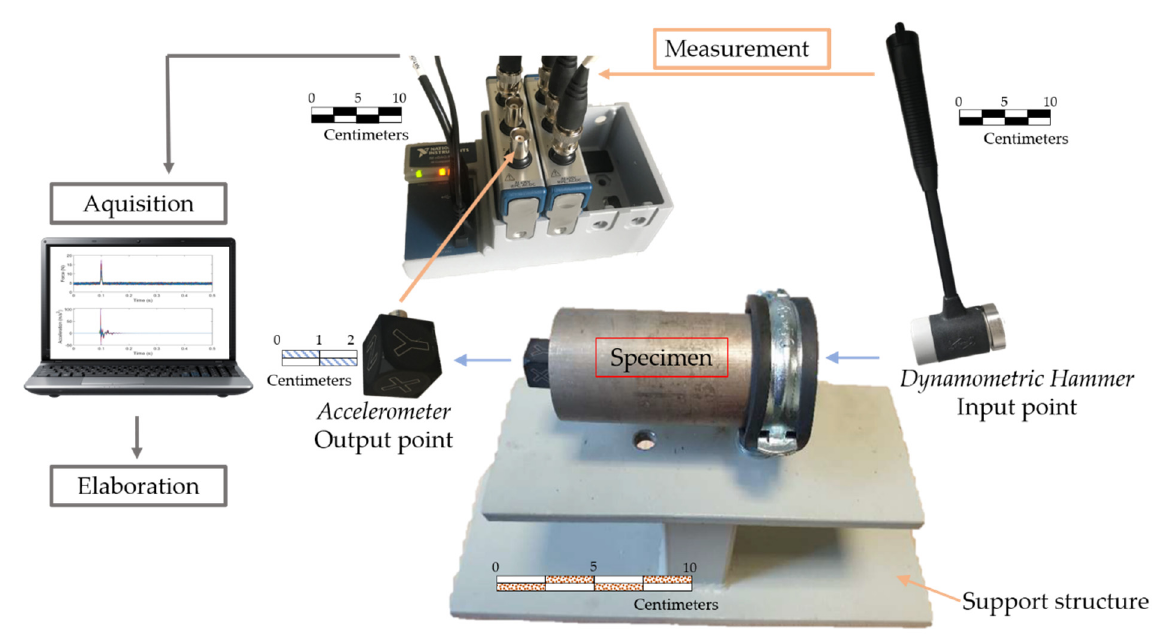
Figure 3. Scheme of the impact test performed, with details of the instruments used.